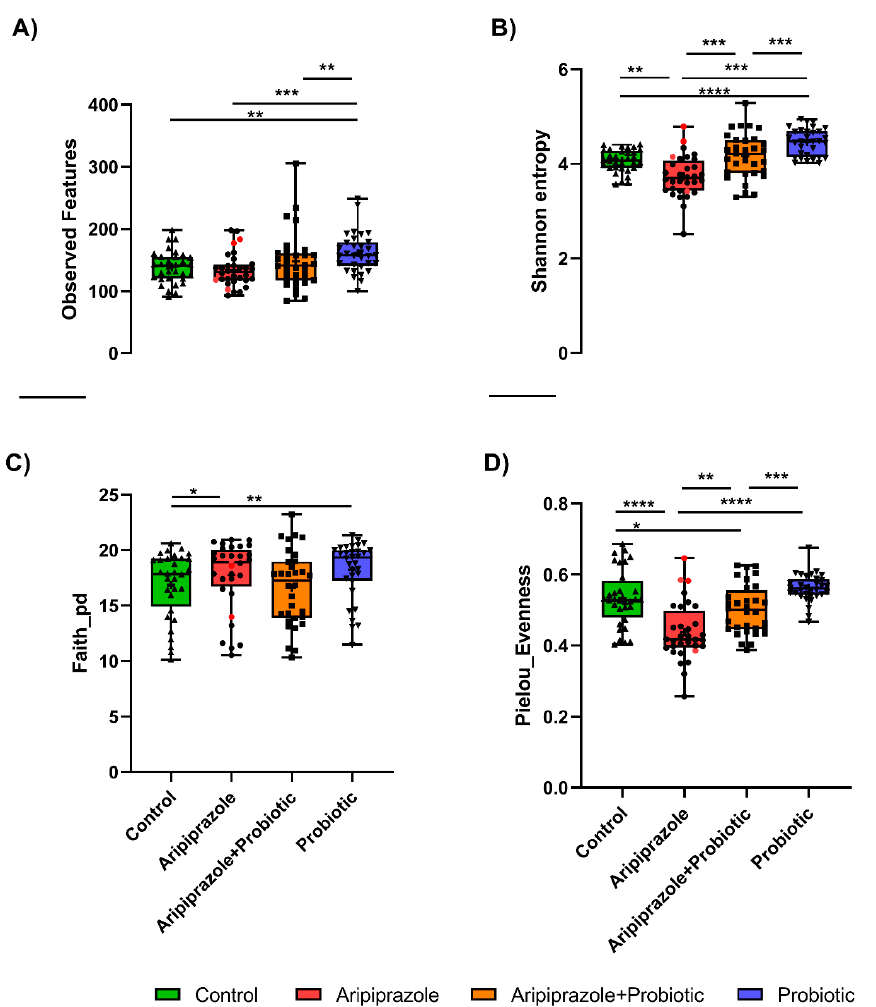
Figure 1. Modulation of microbiota composition following treatment with aripiprazole and probiotics. ( A ) observed features, ( B ) Shannon index, ( C ) Faith’s phylogenetic diversity, and ( D ) Pielou evenness of all treated samples ( n = four biological replicates each). Results were calculated from rarefied 12,000 reads per sample using QIIME2. 2020.6 version. Middle lines represent the mean. Data were analyzed using the Kruskal- Wallis test and Two-stage Benjamini, Krieger, and Yekutieli FDR procedure; * p < 0.05, ** p < 0.01, *** p < 0.001, **** p < 0.0001. Red dots represent the zero time points.